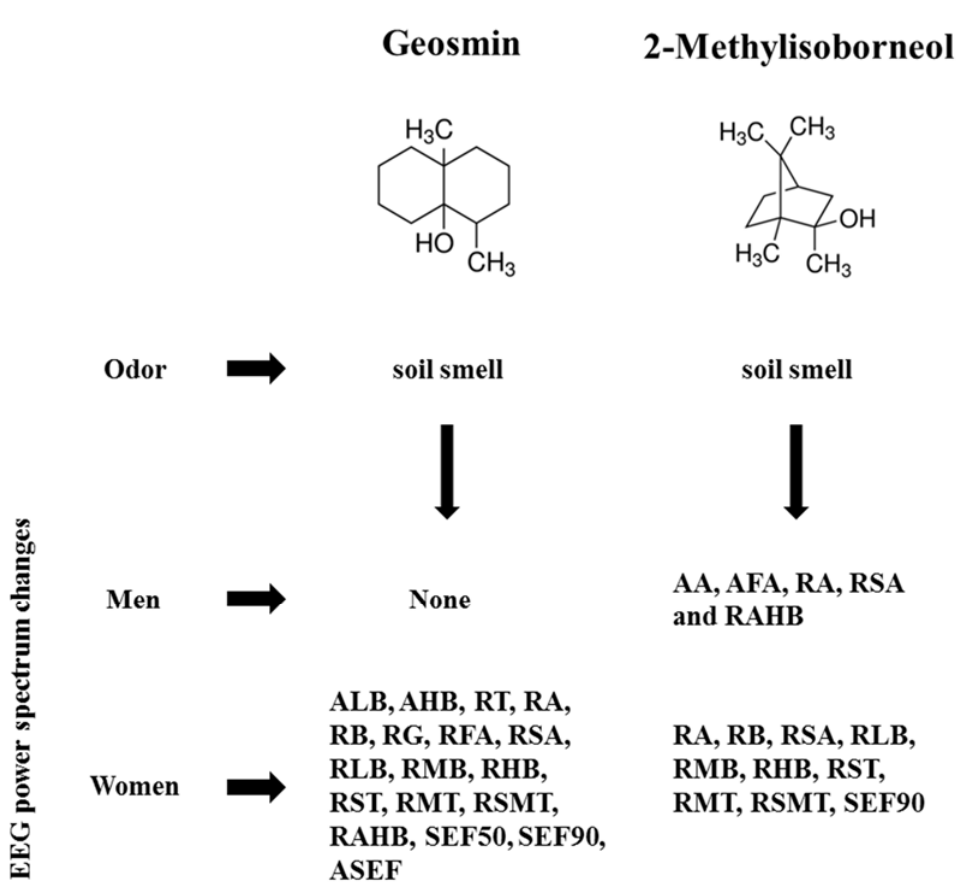
Figure 4. A schematic representation of inhalation of geosmin and 2-methylisoborneol on human EEG activity. AA, absolute alpha; AFA, absolute fast alpha; AHB, absolute high beta; ALB, absolute low beta; RT, relative theta; RA, relative alpha; RB, relative beta; RG, relative gamma; RFA, relative fast alpha; RSA, relative slow alpha; RLB, relative low beta; RMB, relative mid beta; RHB, relative high beta; RST, ratio of SMR to theta; RMT, ratio of mid beta to theta; RSMT, ratio of SMR mid beta to theta; RAHB, ratio of alpha to high beta; SEF50, spectral edge frequency 50%; SEF90, spectral edge frequency 90%; ASEF, spectral edge frequency 50% of alpha.